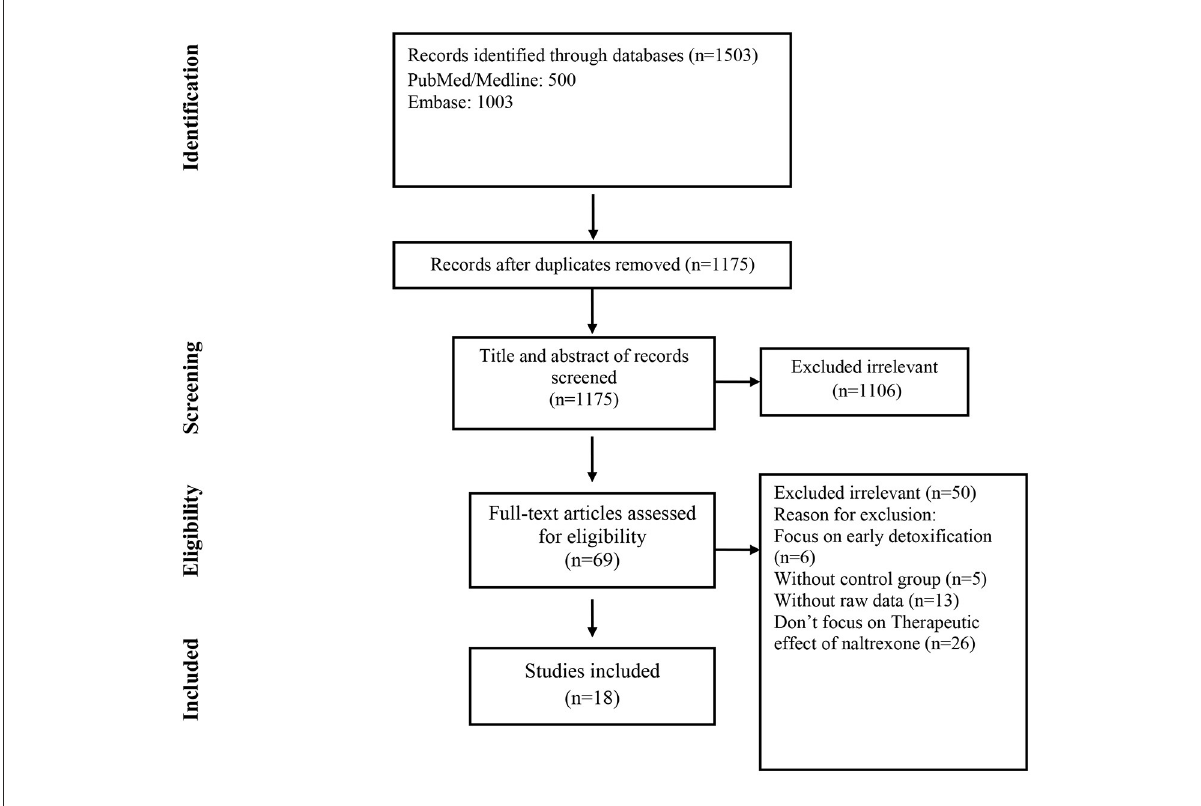
FIGURE1 Flow chart of study selection for inclusion in the systematic review and